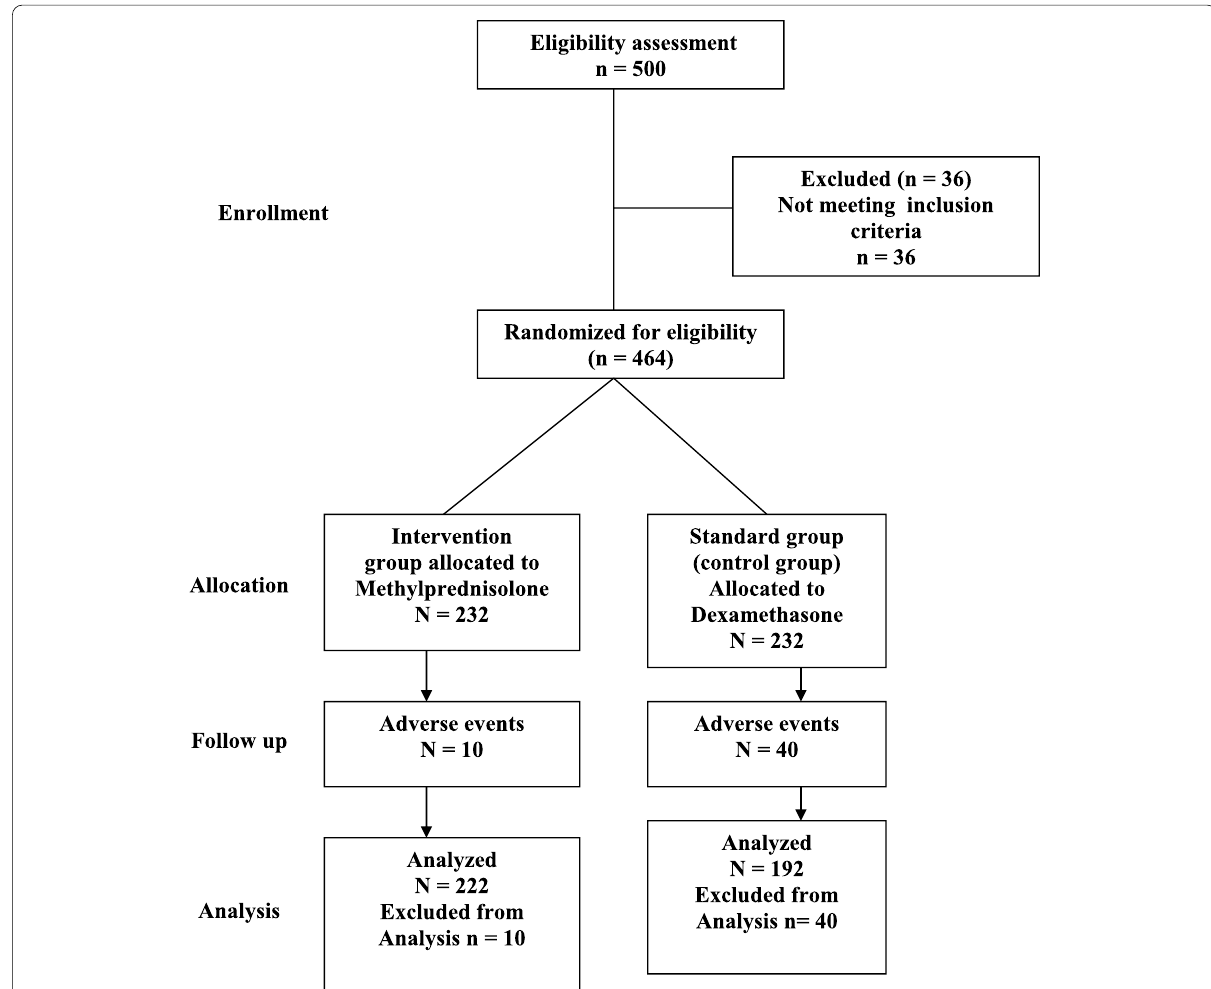
Fig. 1 Flow diagram of a randomized clinical trial of methylprednisolone infusion vs dexamethasone in ARDS ventilated COVID-19 pneumonia